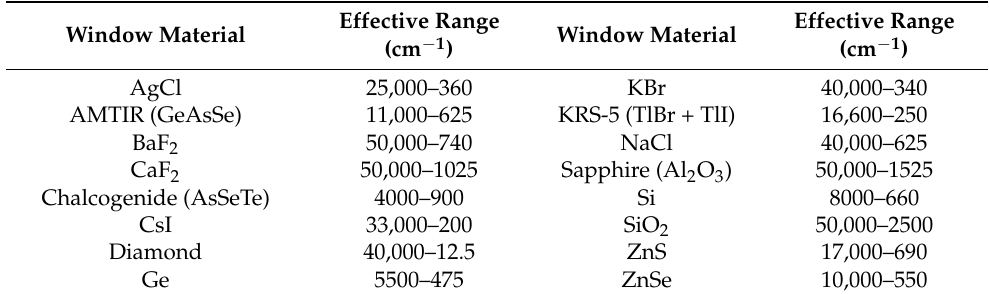
Figure 3. Conceptual scheme of the 10 cm-path gas cell tailored for measuring regasified LNG samples. Table 1. Some common gas cell window materials and their transmission working range [27–29] (there may be slight discrepancies in the wavenumbers among the references).